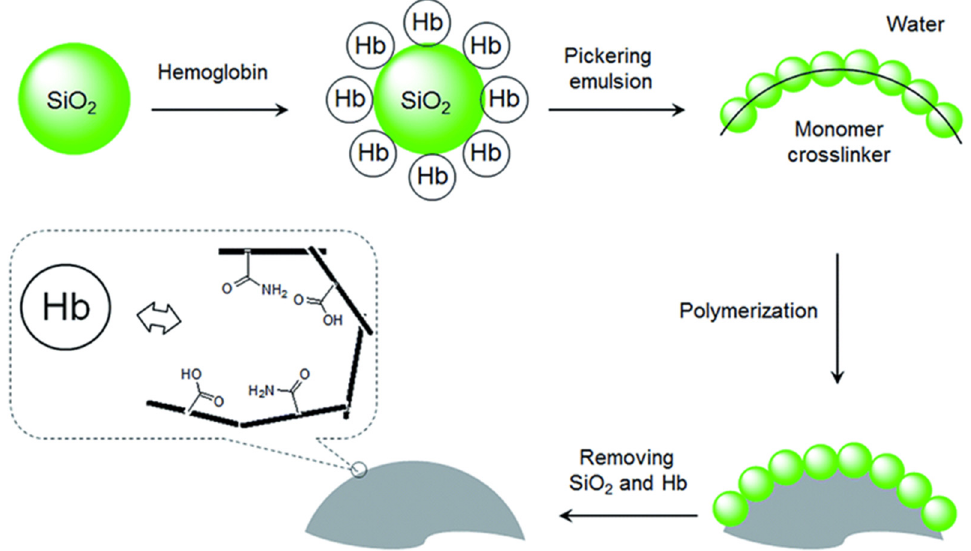
Figure 4. Demonstration of Pickering emulsion procedure for protein imprinting. Reproduced with permission from [55].